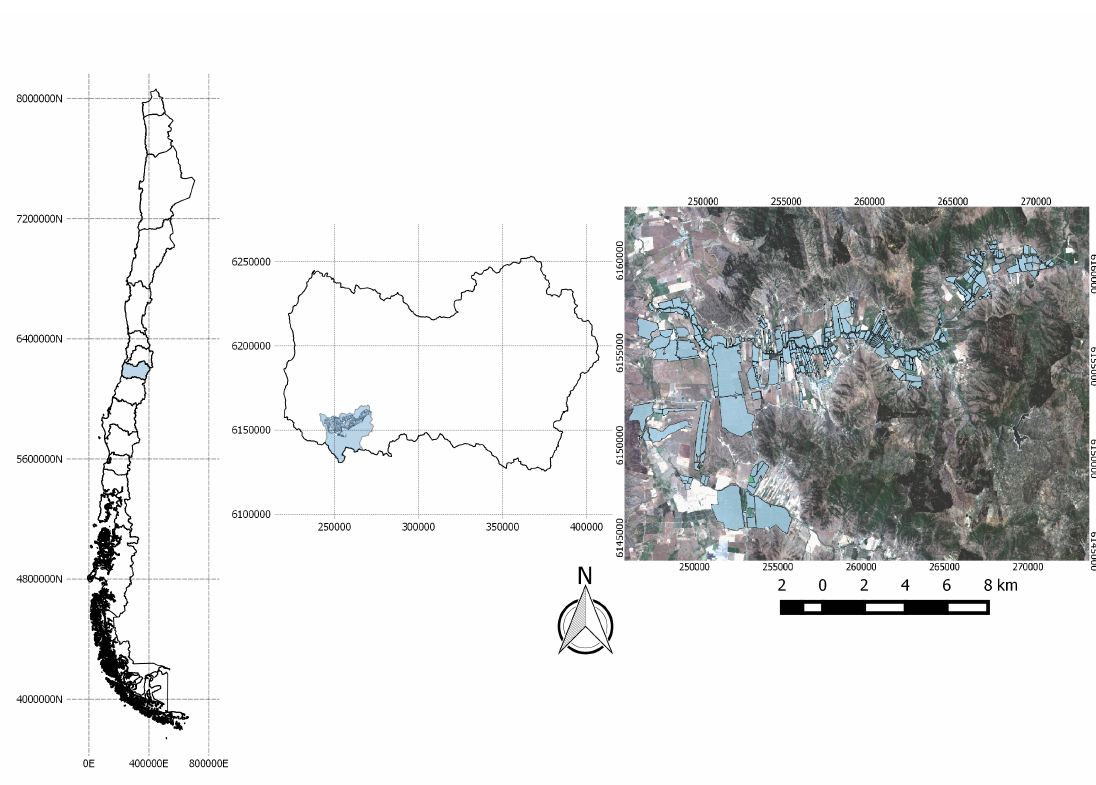
Figure 1. Study site, located in the O’Higgins Region, Chile (252,626.83 E and 6,153,791.95 S, Zone 19, Datum WGS 84). It has an area of 70 km 2